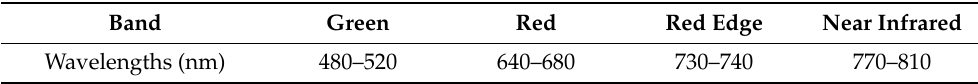
Table 1. Parrot Sequoia wavelength